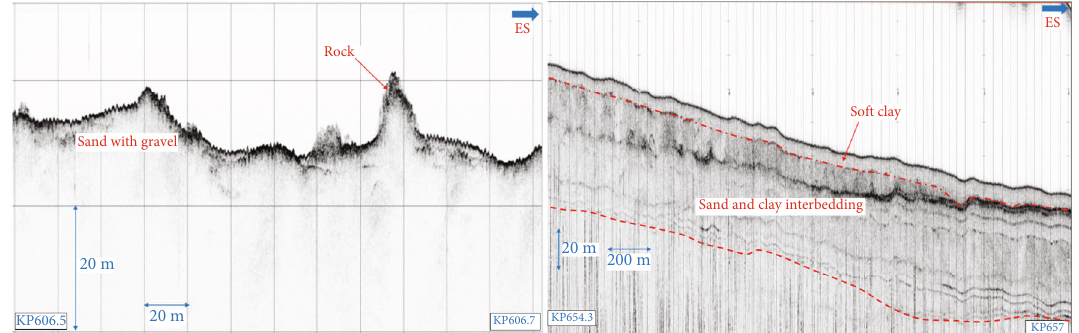
Figure 19: Typical land slope shallow stratigraphic pro fi le (the left fi gure shows the rocks developed in the land slope gully area, and the right fi gure shows the land slope stratigraphic developed